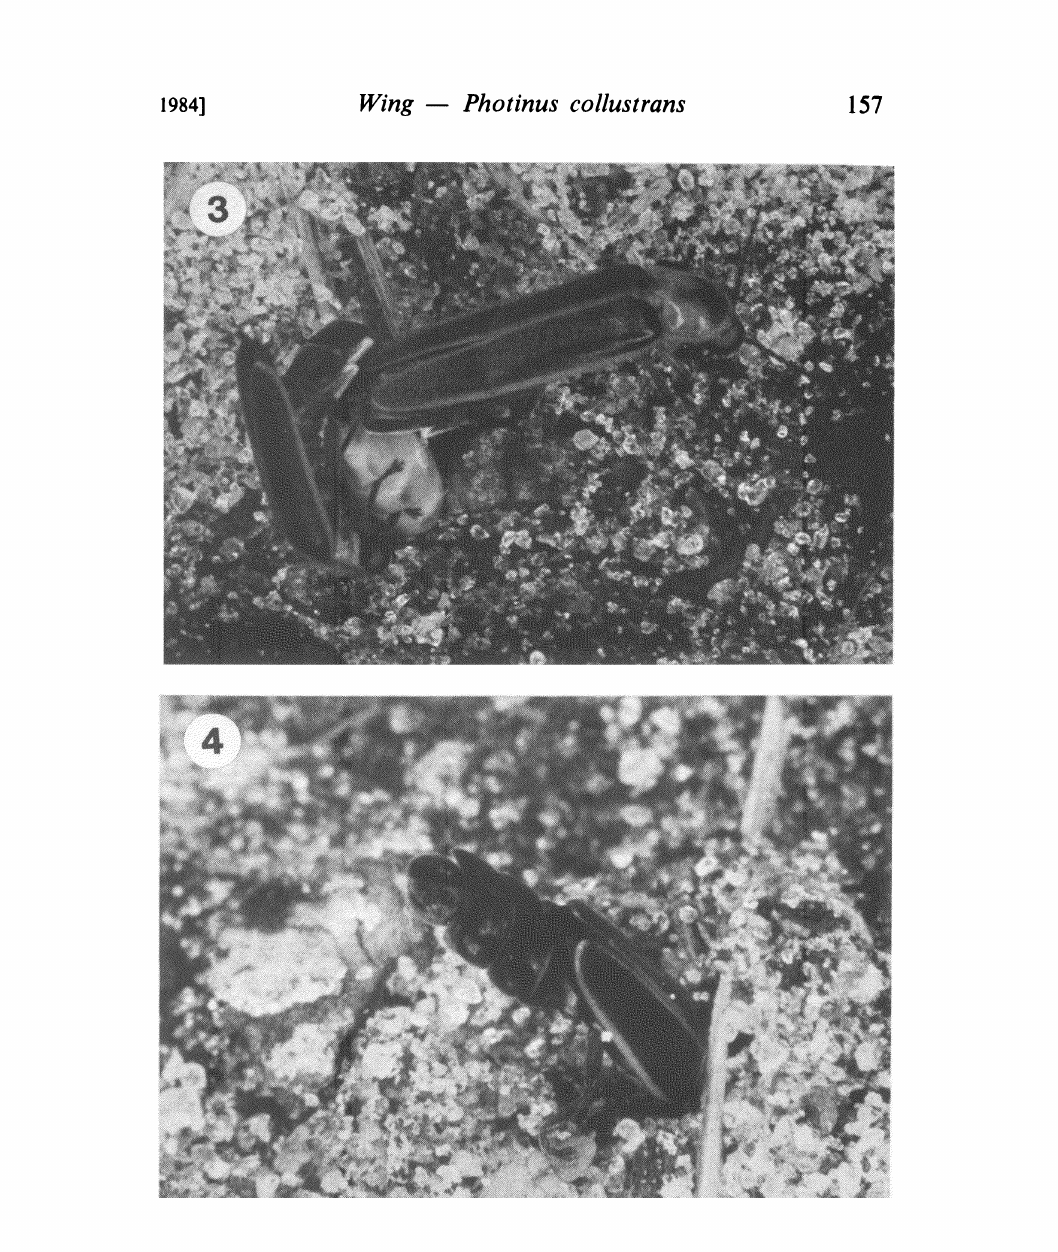
Fig. 3. Rival male (left) remains mounted as female enters burrow. Male on right is copulating. Fig. 4. Rival male digs at female’s